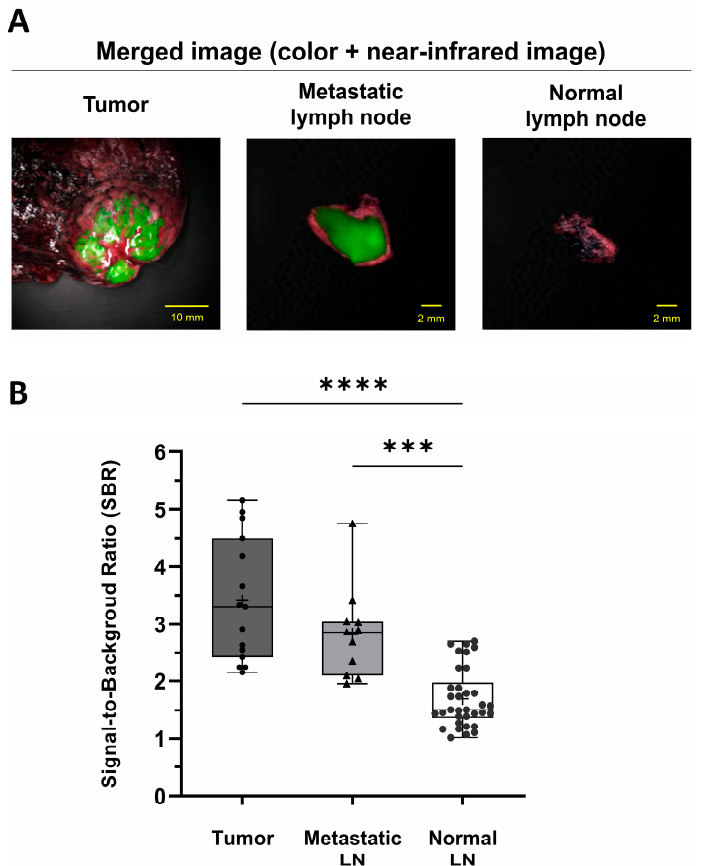
Figure 2. Identification of tumors and metastatic LNs using ICG fluorescence imaging in a patient specimen. A Representative ex vivo fluorescence images of tumors, metastatic LNs, and normal LNs after intravenous injection of ICG (2 mg/kg). B Signal-to-background ratios of the tumors, metastatic LNs, and normal LNs (n = 5; statistical analysis was performed using one-way analysis of variance followed by Tukey’s multiple comparison test; tumors vs. normal LNs, **** P < 0.0001; metastatic LNs vs. normal LNs, *** P < 0.001). LN, lymph node; ICG, indocyanine green.